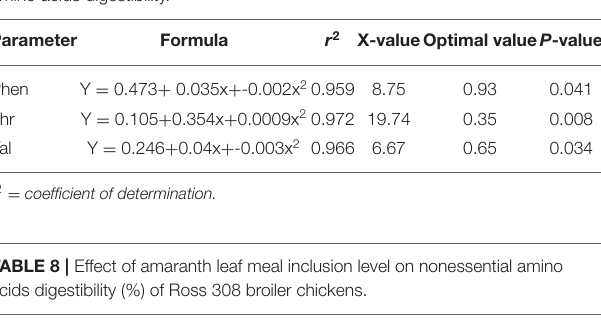
TABLE 9 | Effect of amaranth leaf meal inclusion on gut organ weights (g) of Ross 308 broiler